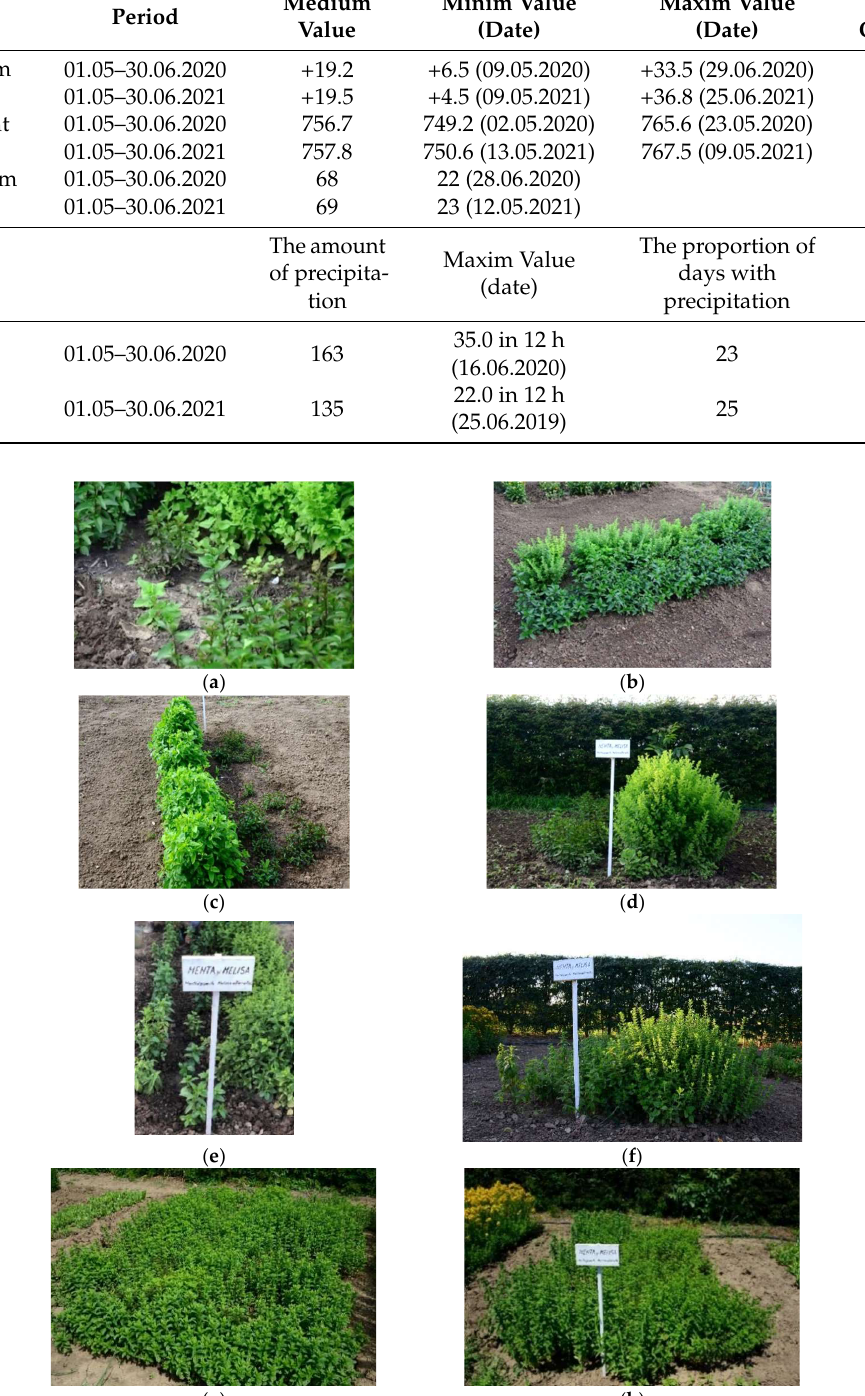
Figure 3. The horizontal evolution of peppermint and lemon balm phytosociological crops during 2018–2021 ( a – h ) (a) Phytosociological crop, May 2018; (b) Phytosociological crop, June 2018; (c) Phy- tosociological crop, May 2019; (d) Phytosociological crop, June 2019; (e) Phytosociological crop, May 2020; (f) Phytosociological crop, June 2020; (g) Phytosociological crop, May 2021; (h) Phytosociolog-